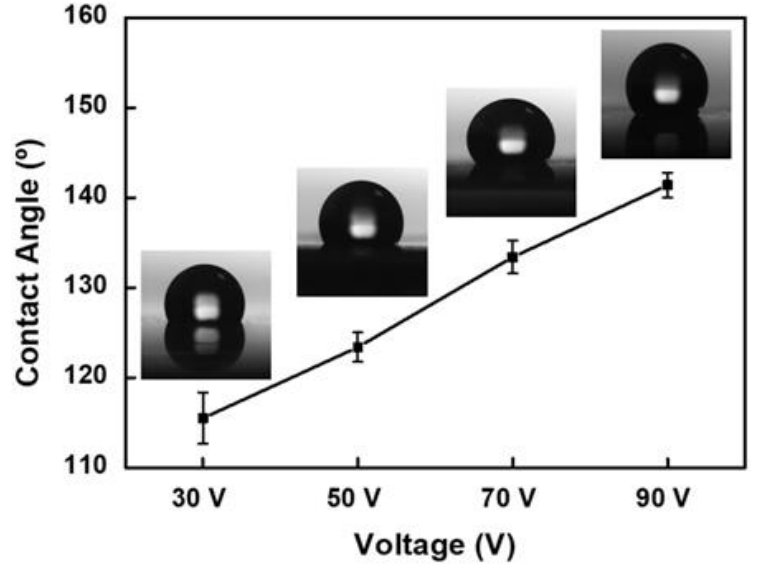
Figure 5. Contact angle after FDTS is coated on the anodized stainless steel 316L sample, at applied voltages of 30, 50, 70, and 90 V.